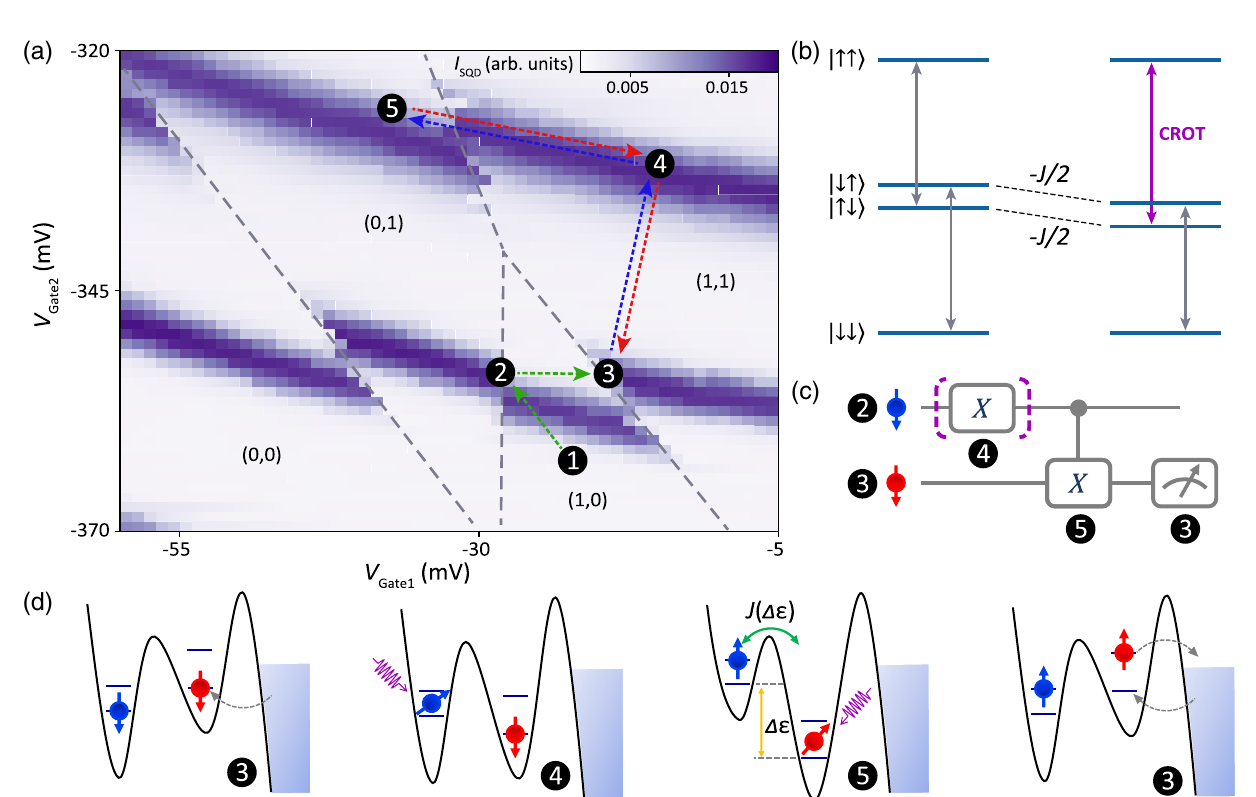
FIG. 1. (a) Charge stability diagram of the DQD and of the pulsing scheme used in the experiment. The current through a sensing quantum dot [ I SQD in arbitrary units (arb. units)] is shown in color scale as a function of two gate voltages that control the electrochemical potentials of the two dots. The gate voltages for steps 1 – 5 in the experiment (discussed in the main text) are indicated with black circles, which also appear in (c) and (d). We note that the DQD remains in the (1,1) state during step 5 (the CROT gate) because the operation is much faster than the tunneling-out time of Q 1 . (b) Spin states of the two-electron system with and without exchange coupling. The spin state of Q 1 is mapped onto the spin state of Q 2 via a CROT gate based on frequency-selective spin transitions. (c) Quantum circuit for the QND readout procedure. Q 1 is used as a logical qubit and as control qubit of the CROT gate, while Q 2 is used as ancilla qubit and as target qubit of the CROT gate. An optional X π pulse is used to prepare Q 1 into the spin-up state following initialization to spin-down. (d) Schematic representation of the DQD system during the QND measurement protocol. Initialization and readout are implemented by aligning the electrochemical potential of the last electron in dot 2 close to the Fermi energy of the reservoir. The exchange coupling is switched on by detuning the electrochemical potentials of dots 1 and 2. Both electrochemical potentials are varied by applying voltage pulses on the depletion gates that define the DQD confining potential. Spin flips in single- and two-qubit gates are implemented by